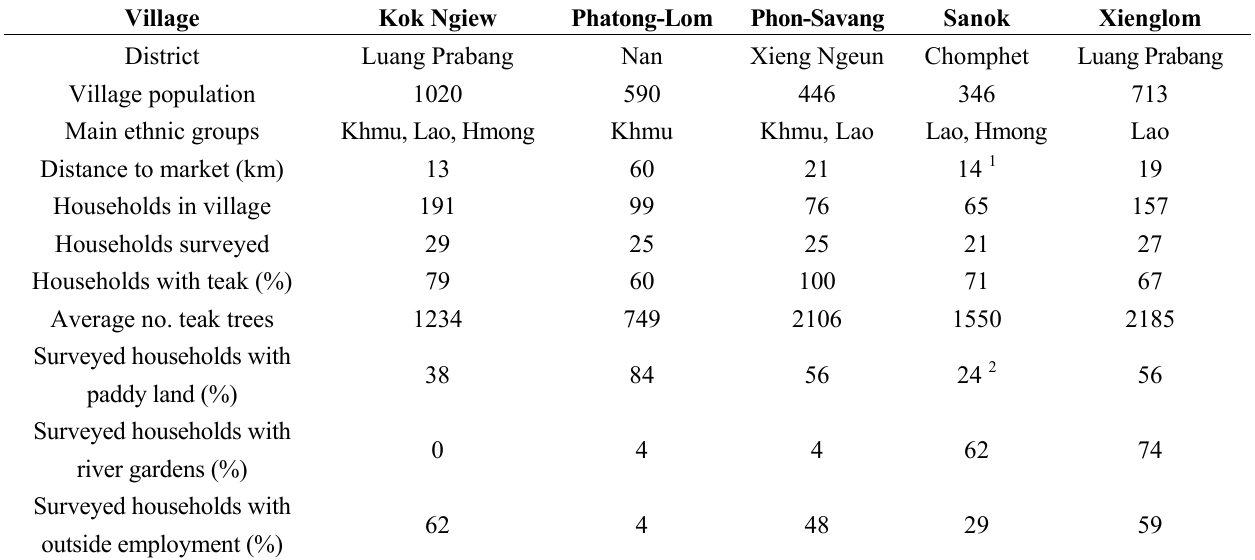
Table 1. Case study villages and